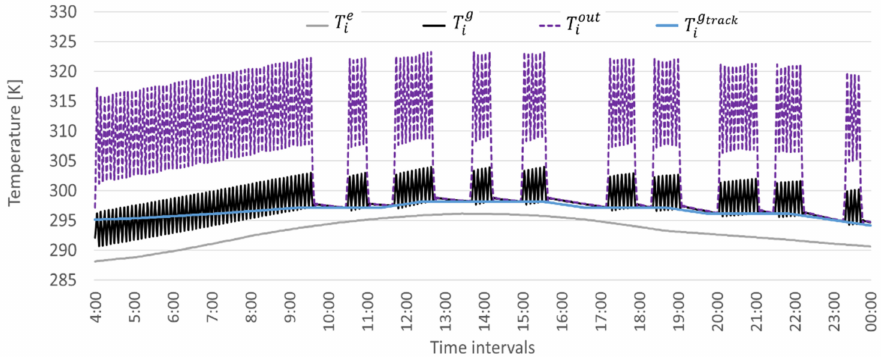
Figure 7. Input and state variables associated with the temperature in reactive approach ( crt = 1 )